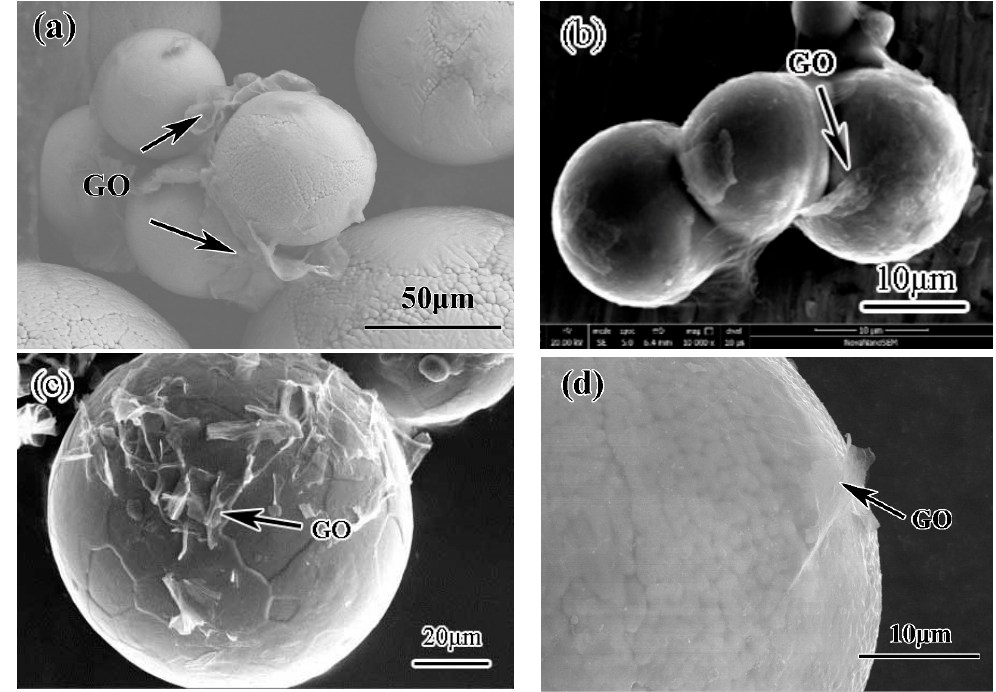
Figure 2. Scanning electron microscopy (SEM) images of the graphene oxide (GO)-coated TiAl powders: ( a ) original, ( b ) CTAB-modified, ( c ) PVA-modified, and ( d ) milled by PVA-modified.